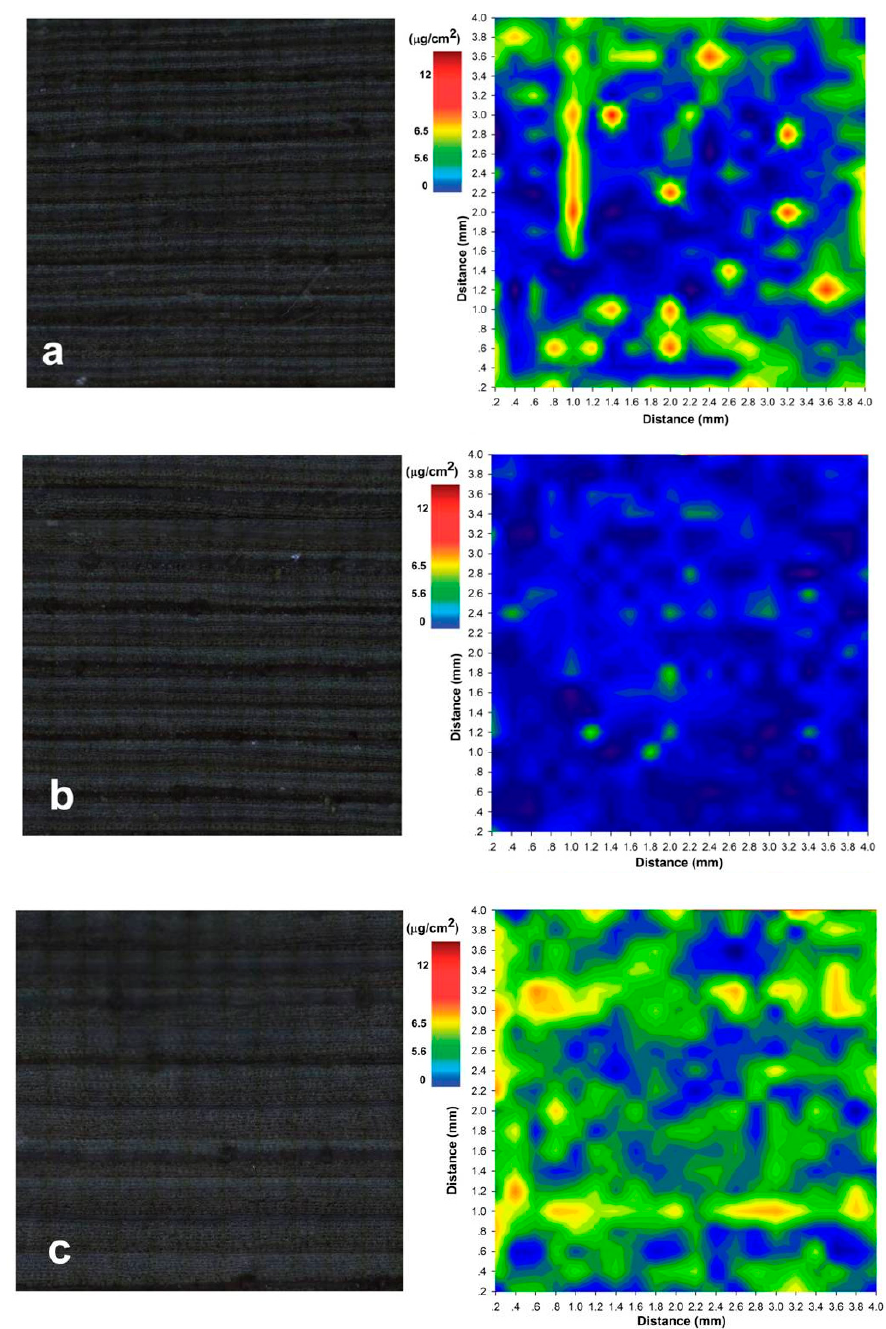
Figure 5. The 2D mapping results of chlorpyrifos on a leaf surface using LipsImag. ( a ) The mapping result of pesticide on a leaf that used 100 mL chlorpyrifos EC (40.7%) diluted by 50 L water and was subsequently sprayed in a 1 mu (666.7 m 2 ) maize field; ( b ) The mapping result of a lower concentration of pesticide that used 10 mL chlorpyrifos; ( c ) The mapping result of the leaf 10 h after spray application that used 100 mL chlorpyrifos EC. The left image of ( a – c ) shows the visible image observed by microscopy, while the right image is the scanning results that show the distribution of the pesticide.